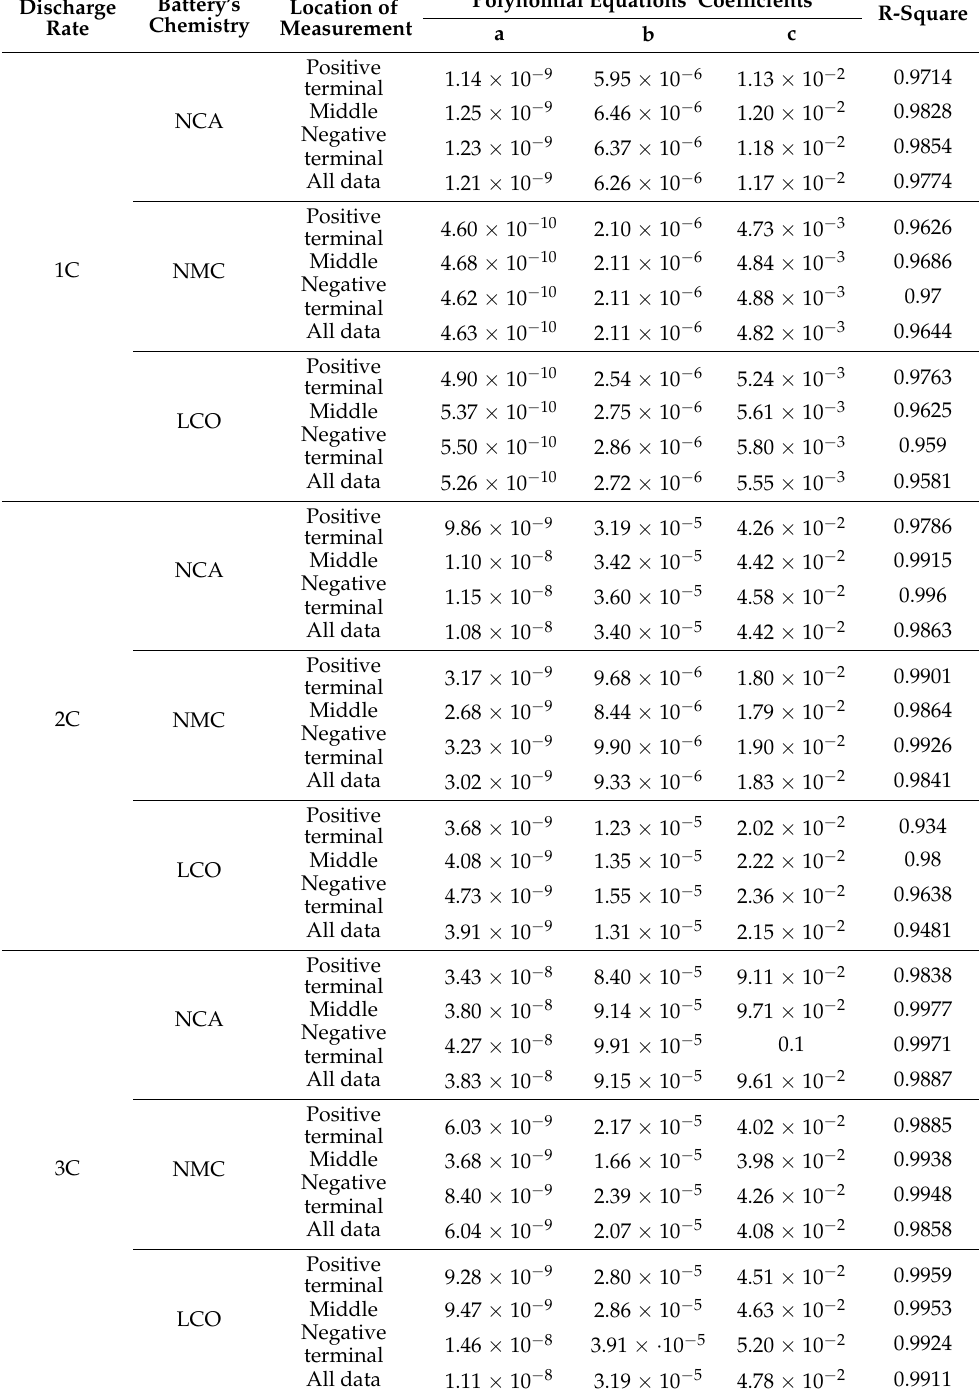
Table 2. Third-order polynomial equations’